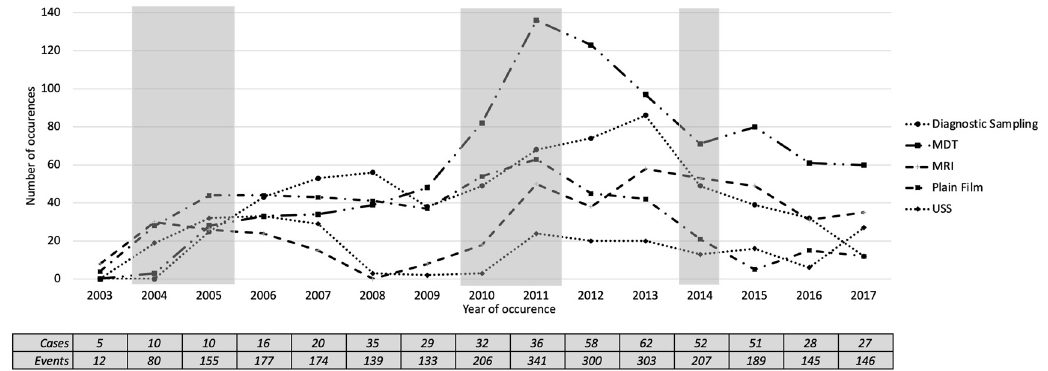
Figure 9. The total number of patients undergoing each of the five most frequent investigation categories (2003–2017). The shaded areas show the periods where change might have occurred at the activity